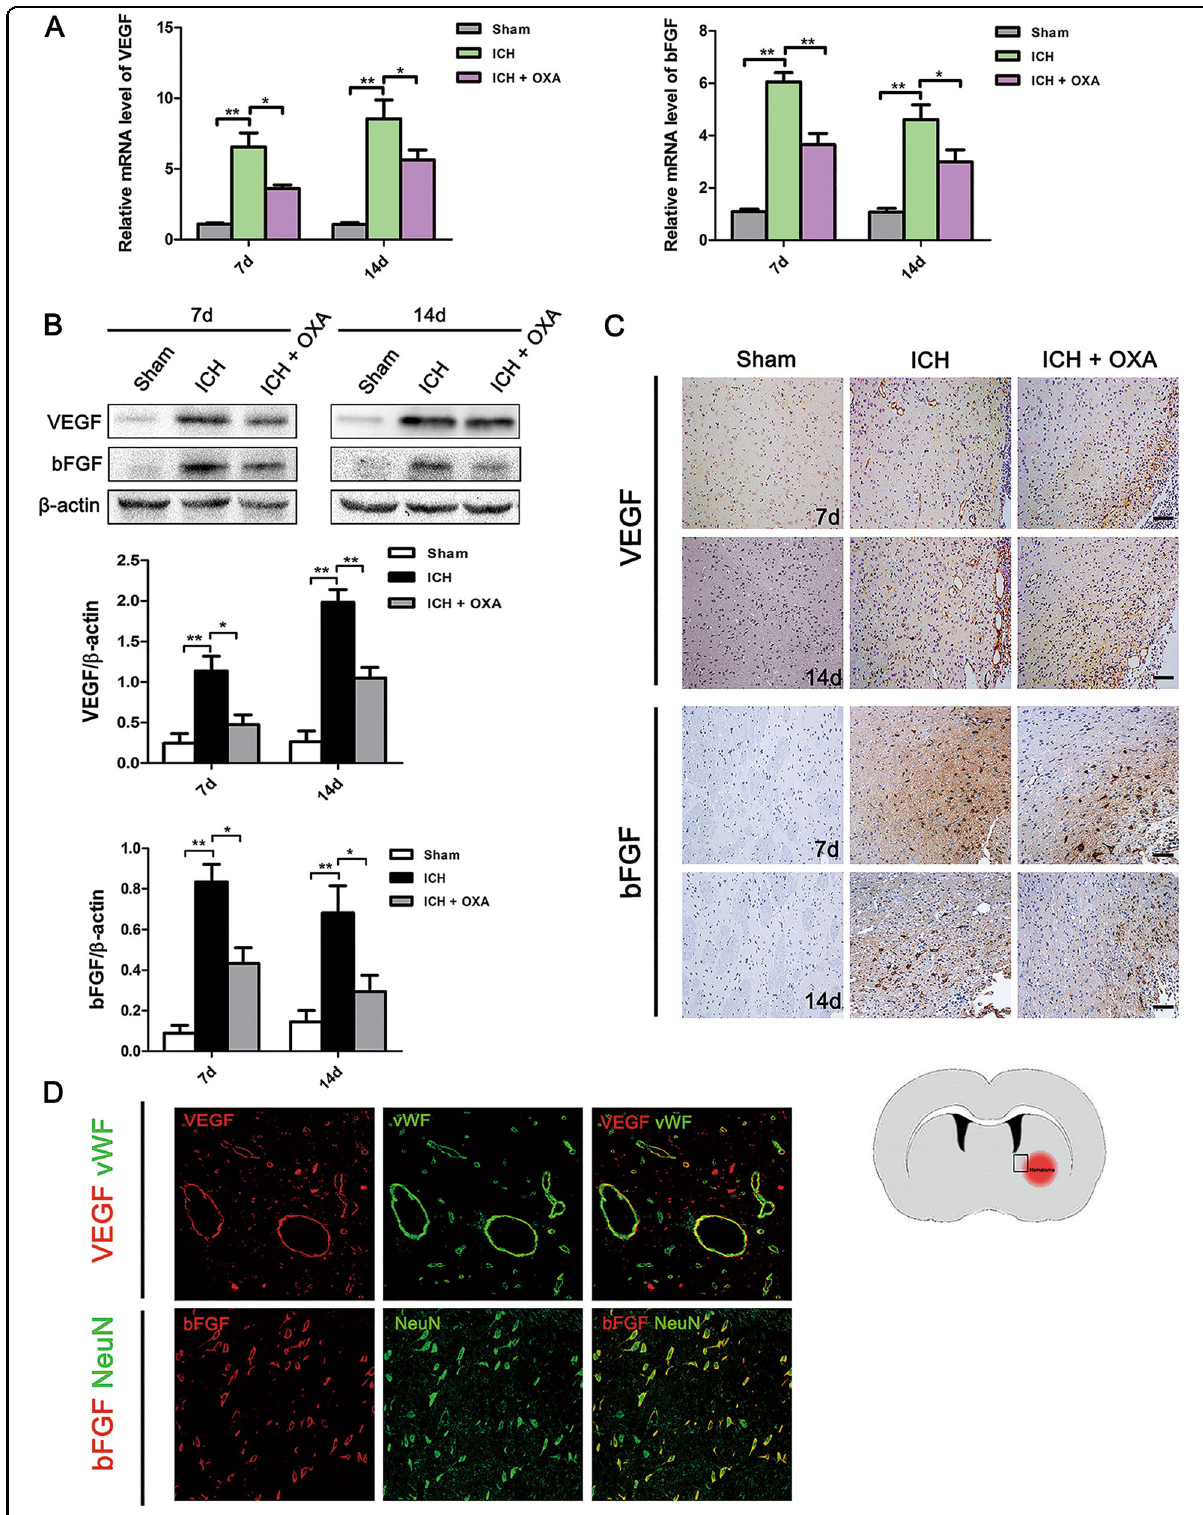
Fig. 4 a Levels of VEGF and bFGF mRNAs were dramatically decreased in the OXA-treated group after ICH. b Western blot analysis showed that the expression levels of VEGF and bFGF were signi fi cantly upregulated after ICH. OXA suppressed this upregulation. c After ICH, many VEGF + microvessels and bFGF + cells were detected around the hematoma. d Immuno fl uorescent double labeling con fi rmed that VEGF was localized in vWF-positive vessels and that bFGF was localized to NeuN-positive cells. ICH intracerebral hemorrhage, OXA oxamate. * p < 0.05 and ** p < 0.01. n = 5. Scale bar = 100 μ